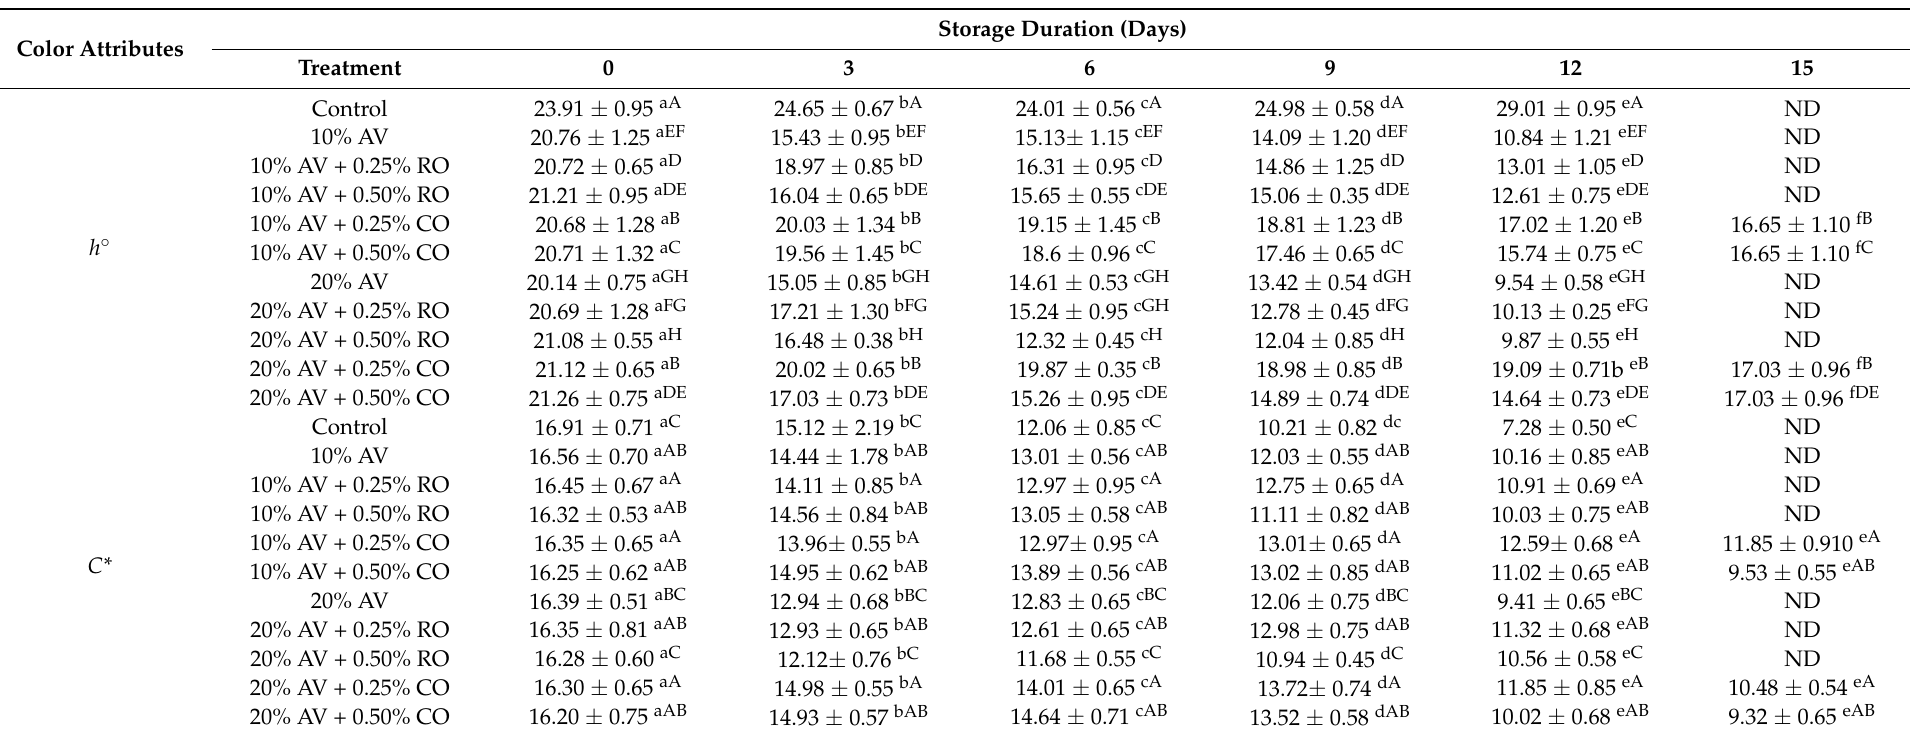
Table 1. The effects of Aloe vera (AV) gel coating that was enriched with rosehip oil (RO) (0.25% or 0.50%) and cinnamon oil (CO) (0.25% or 0.50%) on the color attributes that are reported as the hue angle ( h ◦ ) and chroma ( C* ) of ‘Bhagwa’ pomegranate arils during storage at 5 ± 1 ◦ C (95 ± 2% RH) for 15 days.